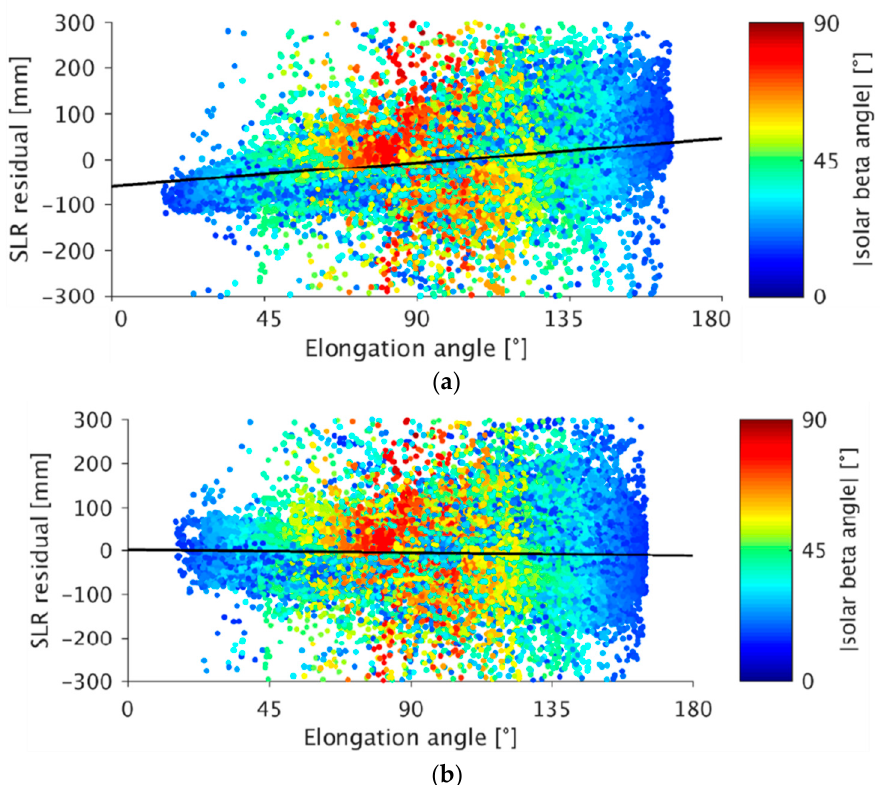
Figure 13. ( a ) SLR residuals to GLONASS-M orbits from IGS-repro02 using the original Empirical CODE Orbit Model (ECOM). ( b ) SLR residuals to GLONASS-M orbits from EGSIEM-REPRO using the extended ECOM. For both figures, residuals between January 2003 and December 2013 are shown. Observations for four GLONASS satellites (space vehicle number (SVN) 723, 725, 736, 737) were excluded due to anomalous patterns. Residuals of these GLONASS satellites increased after a certain time after launch [29]. Furthermore, residuals with absolute beta angles smaller than 15 ◦ are not shown due to unmodeled attitude behavior during eclipses. The black line indicates the linear regression of the SLR residuals as a function of the elongation angle.